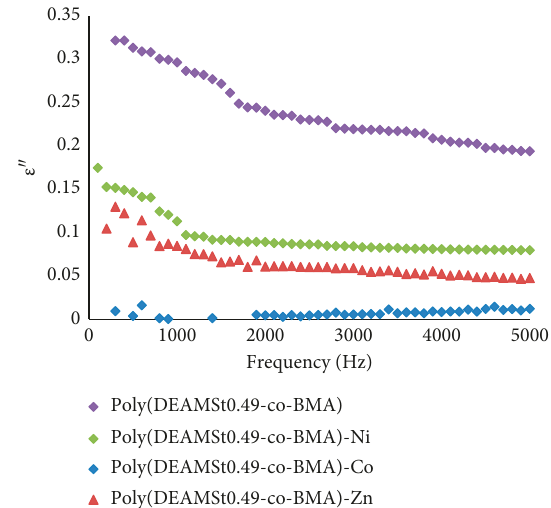
Figure 12: Dielectric loss factor change of the poly(DEAMSt0.49- co-BMA) ligand and the poly(DEAMSt0.49-co-BMA)-M metal complexes versus frequency (M: Co(II), Ni(II),